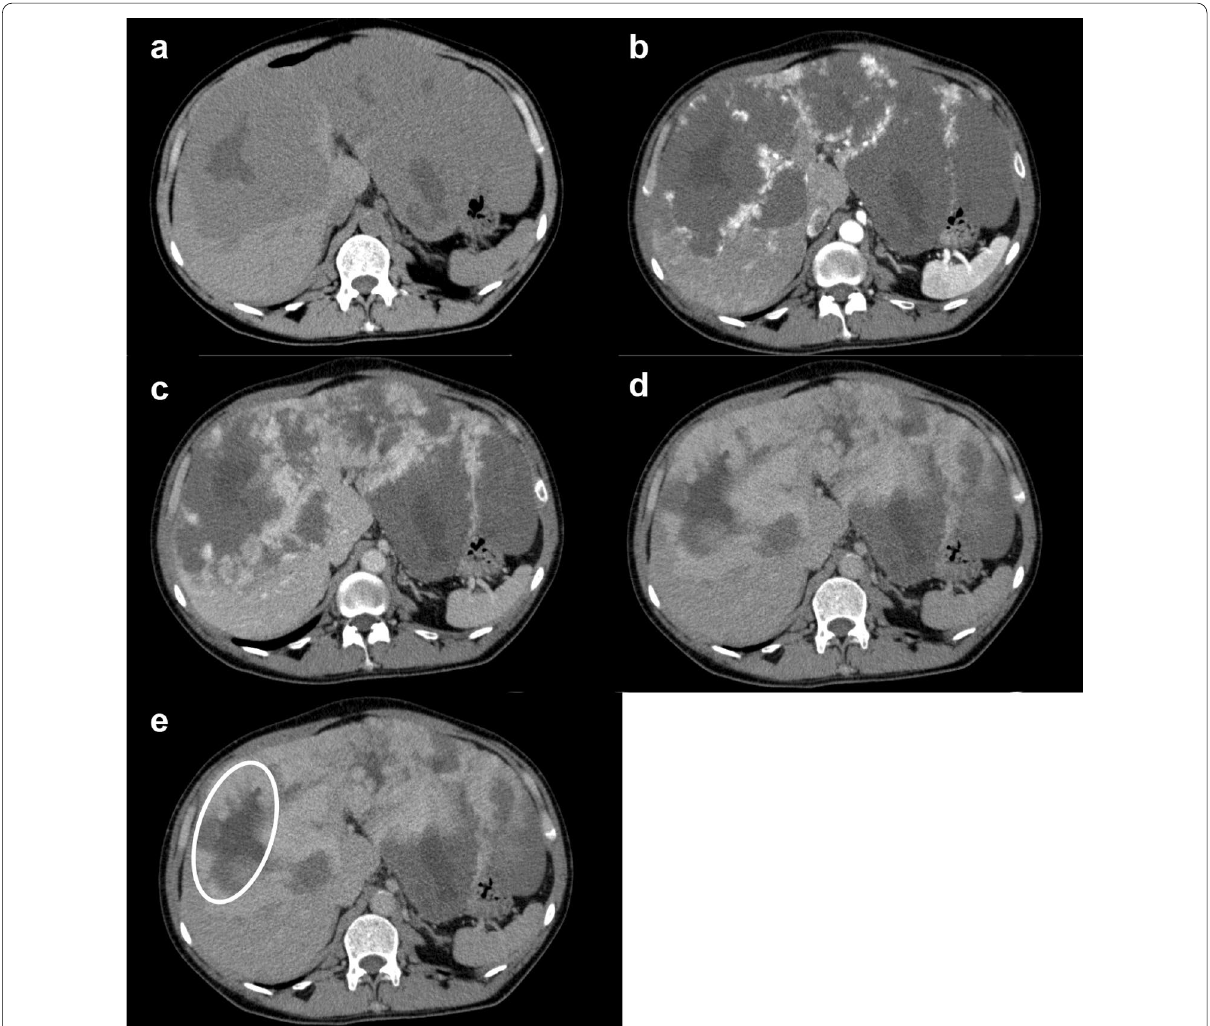
Fig. 4 Cavernous hemangioma of the liver. a Unenhanced series. Native computed tomography showed multicentric, low density, well-defined tumors with central hypodensity. b In the arterial phase, early staining of the peripheral part of the tumor was observed. c–e Portal venous (parenchymal) and delay phase showed extension of the contrast effect to the center. An area that was not enhanced was observed in the tumor (white